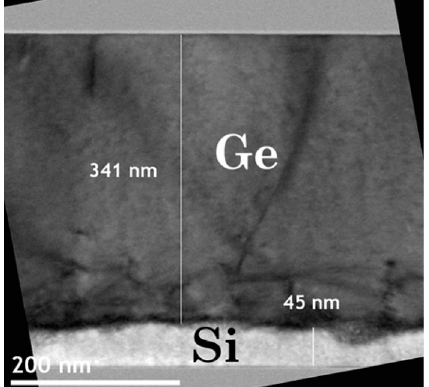
Figure 2: Cross-sectional transmission electron microscopy image of a Si cavity after Ge epitaxial growth and chemical mechanical polishing steps. Figure adapted with permission from a study by Virot et al. [106] © Chinese Laser